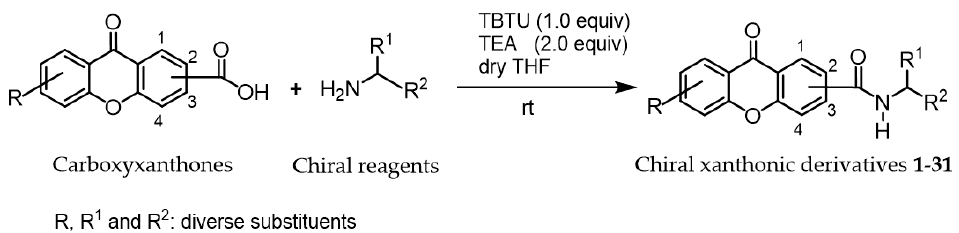
Figure 2. Chemical structures of chiral xanthonic analytes 1 – 31 .